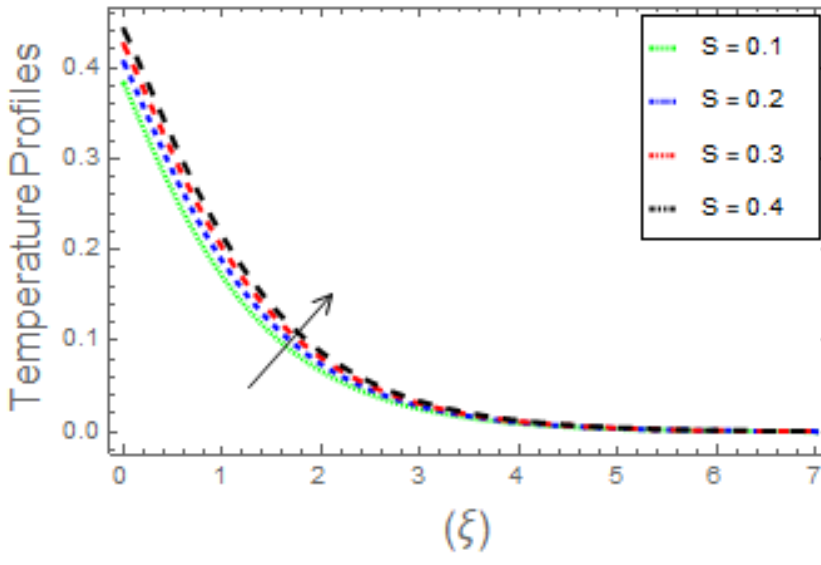
Figure 16. Variation in T due to S .